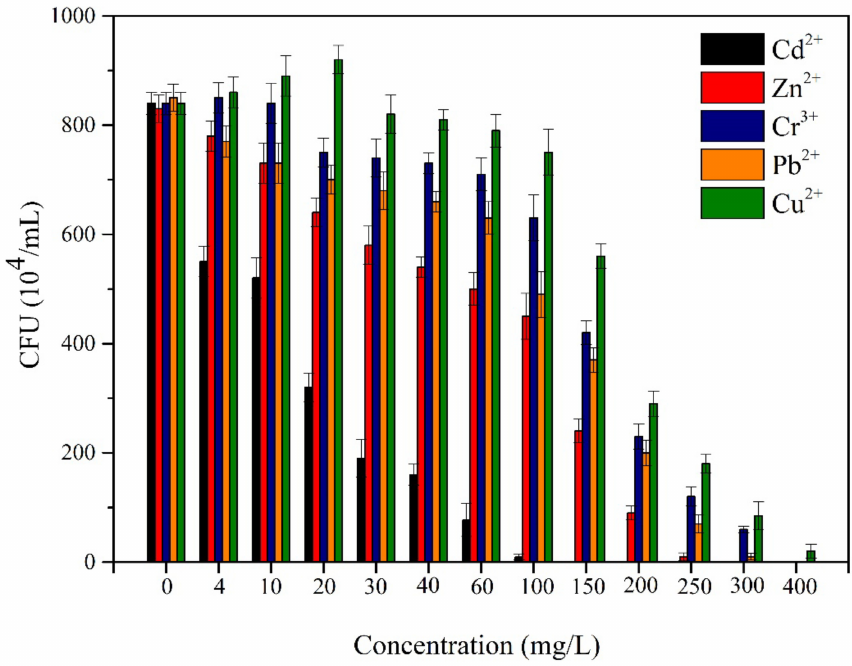
Figure 3. The tolerance of Acinetobacter sp. SCYY-5 to 5 heavy metals: Cu 2+ , Cd 2+ , Zn 2+ , Pb 2+ , and Cr 3+ . The general order of resistance of Acinetobacter sp. SCYY-5 to heavy metals is as follows: Cd 2+ < Zn 2+ < Pb 2+ = Cr 3+ < Cu 2+